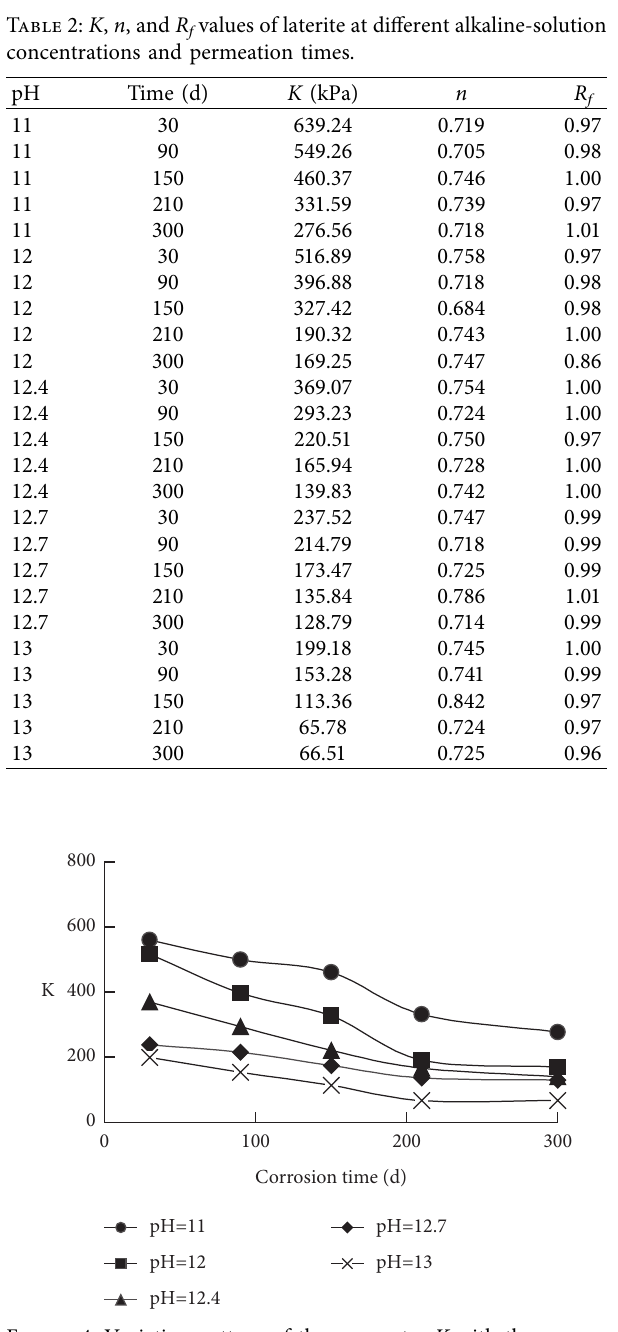
Figure 4: Variation pattern of the parameter K with the perme- ation time at different alkaline-solution concentrations.